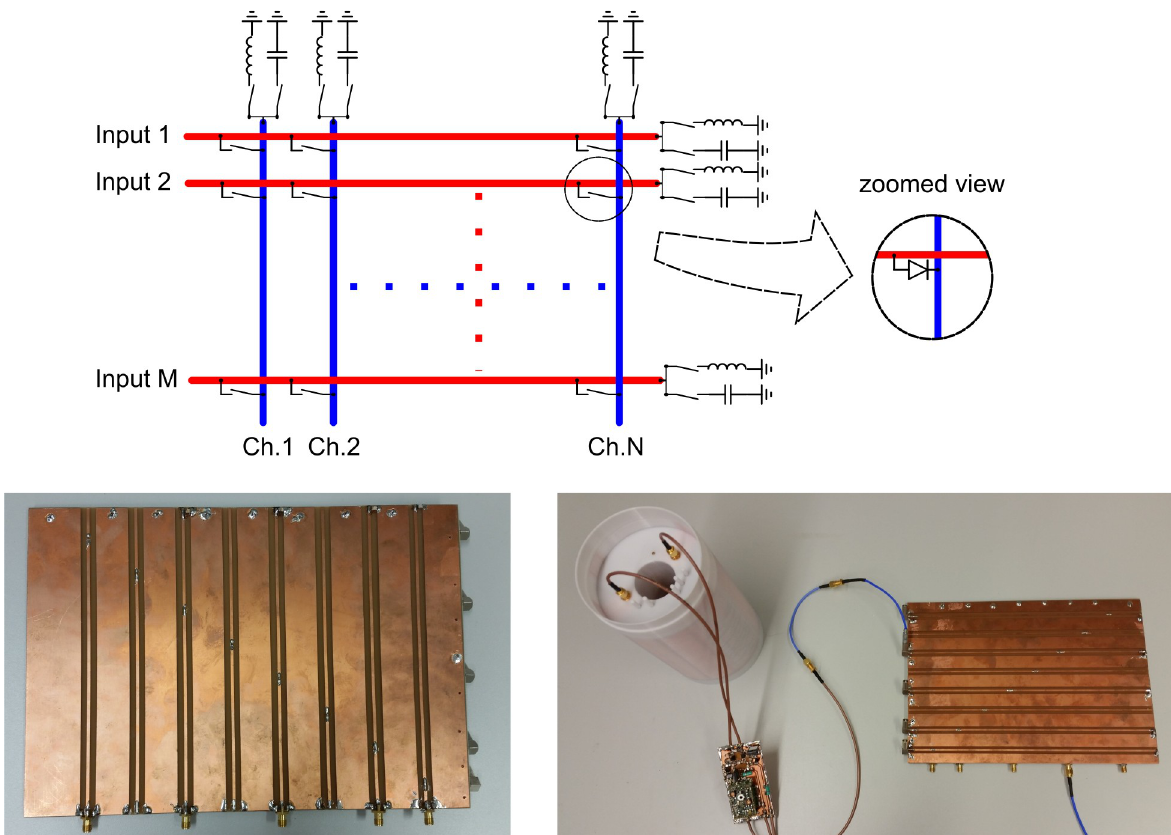
Fig 1. Topology of a crossbar switch matrix (top) and prototype board (bottom). The top image shows an M-input x N-output freely configurable crossbar switch matrix using SPST switches. Selectable compensation elements, e.g. one capacitor and one inductor are located at the end of each transmission line stub. The SPST switches can be realized as a single PIN diode. The bottom images show the prototype PCB as well as the prototype connected to a birdcage coil including preamplifier and transmit/receive